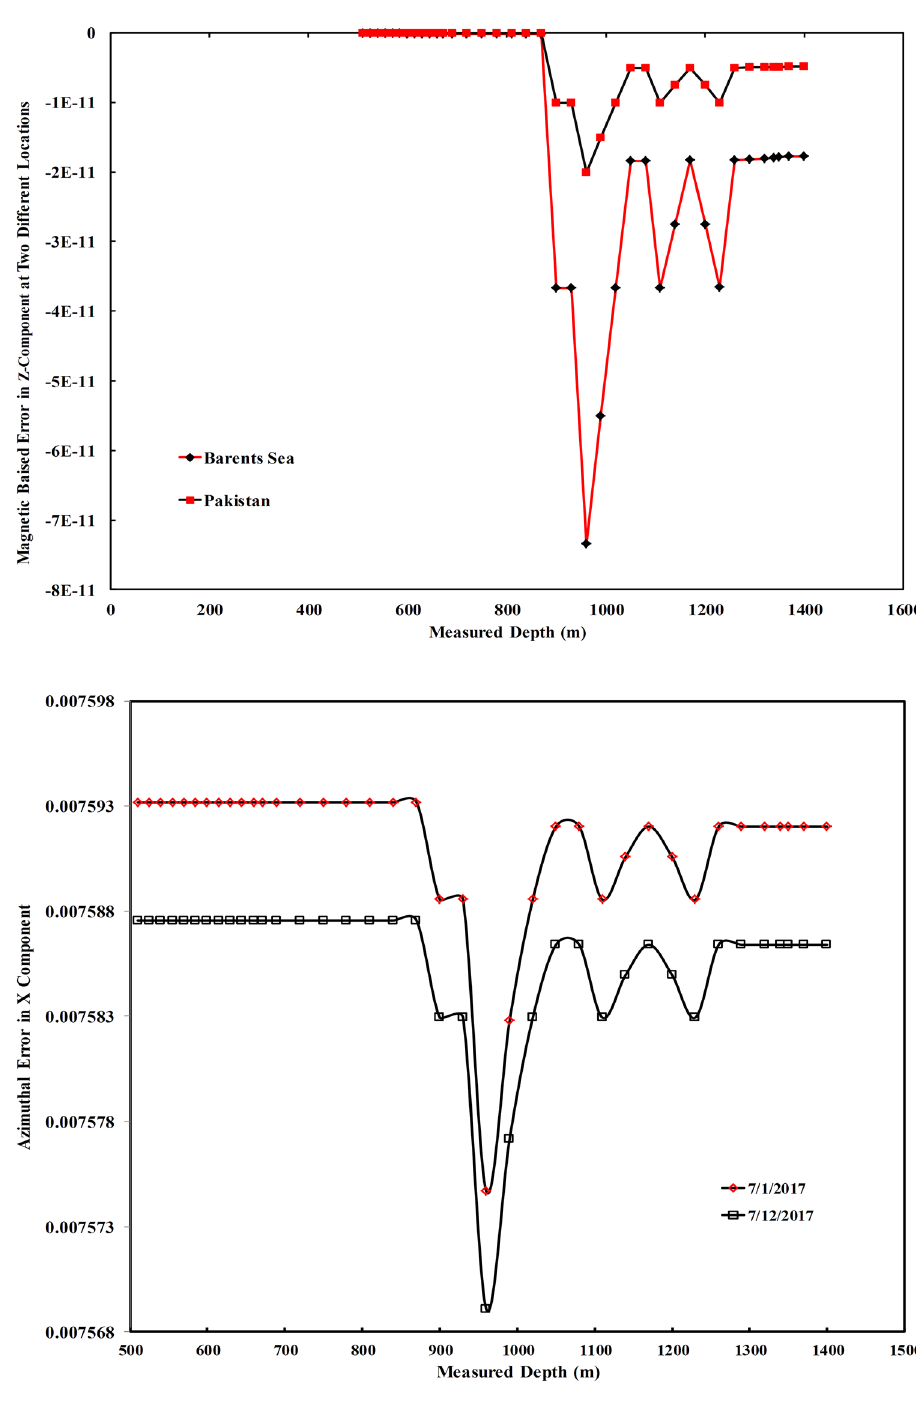
Fig. 7 Comparison between two different regions’ magnetometer biased errors